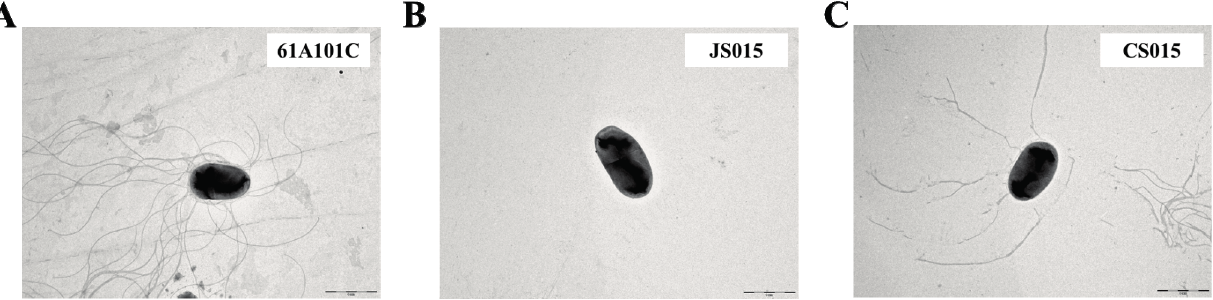
Figure 5. Electron microscopic analysis of flagella from the wild type ( A ); the waaL knock-out mutant ( B ); and its complemented strain ( C ). Bars = 5